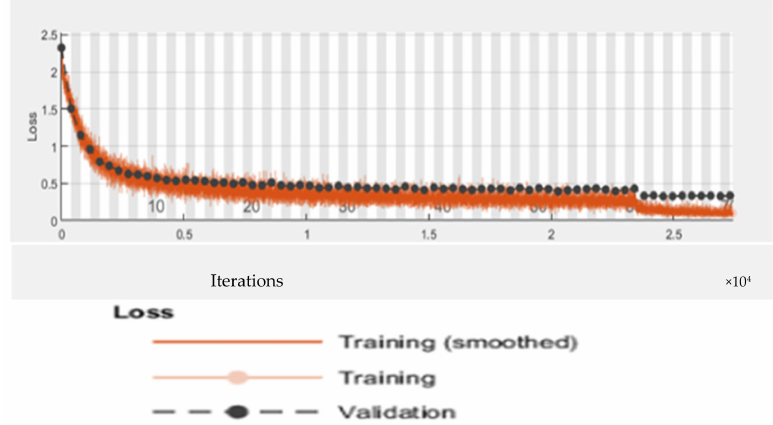
Figure 11. CNN model